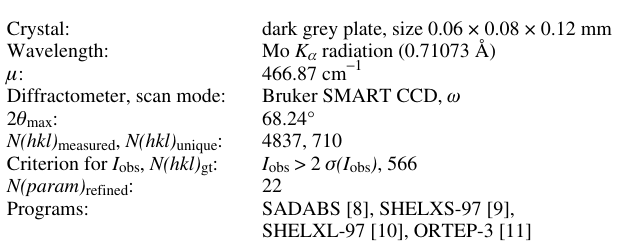
Table 1. Data collection and handling.